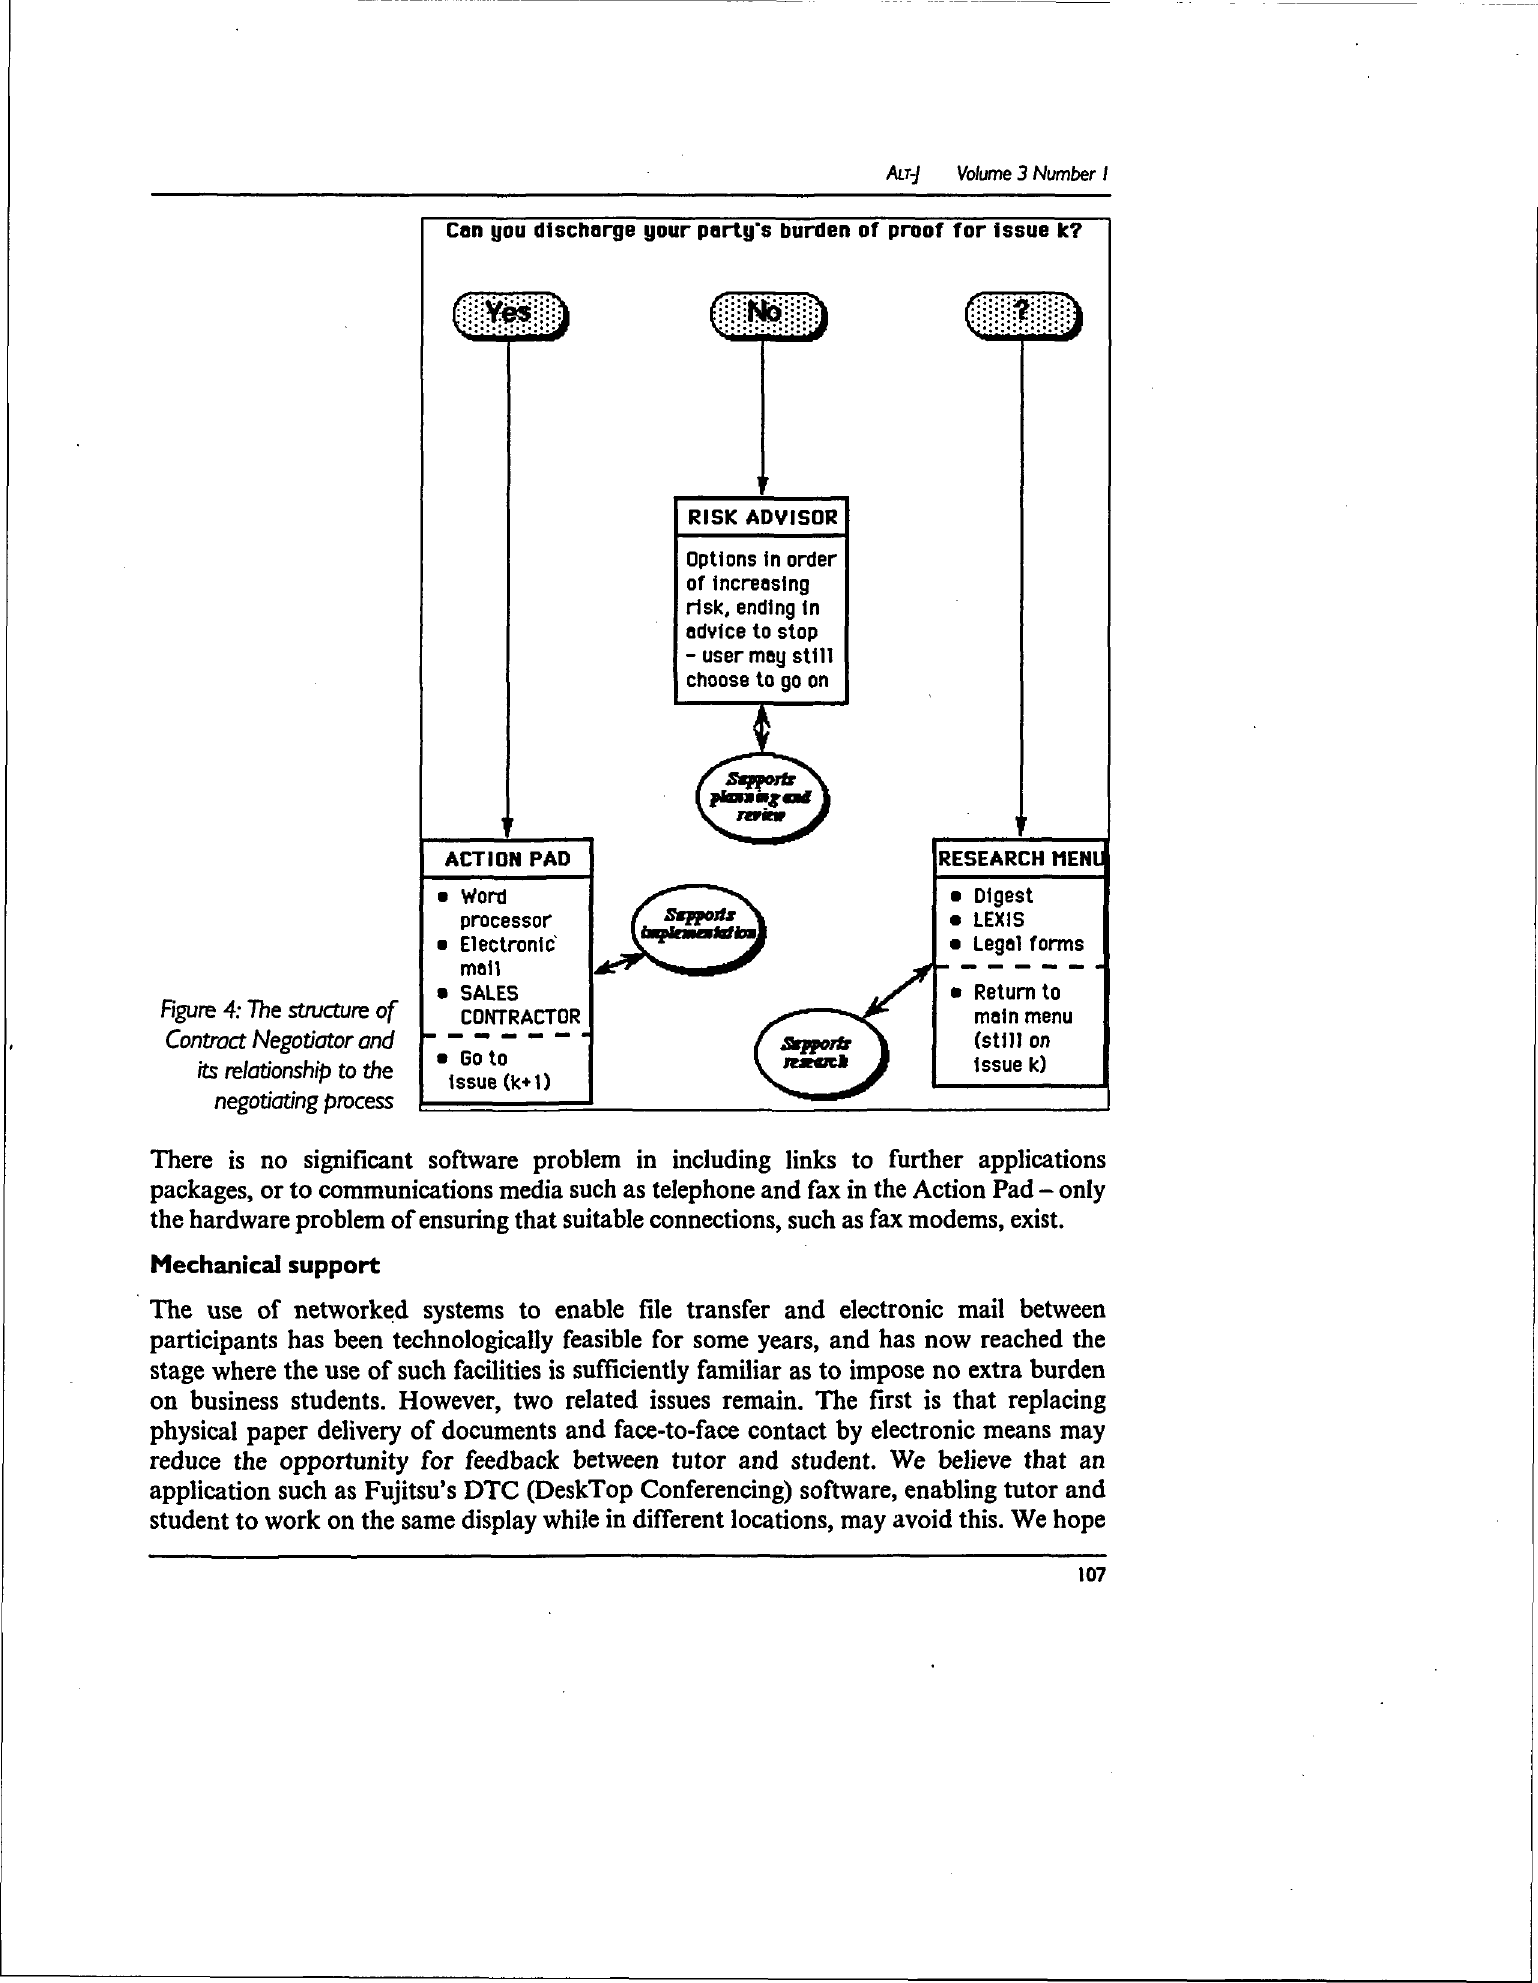
Figure 4: The structure of Contract Negotiator and its relationship to